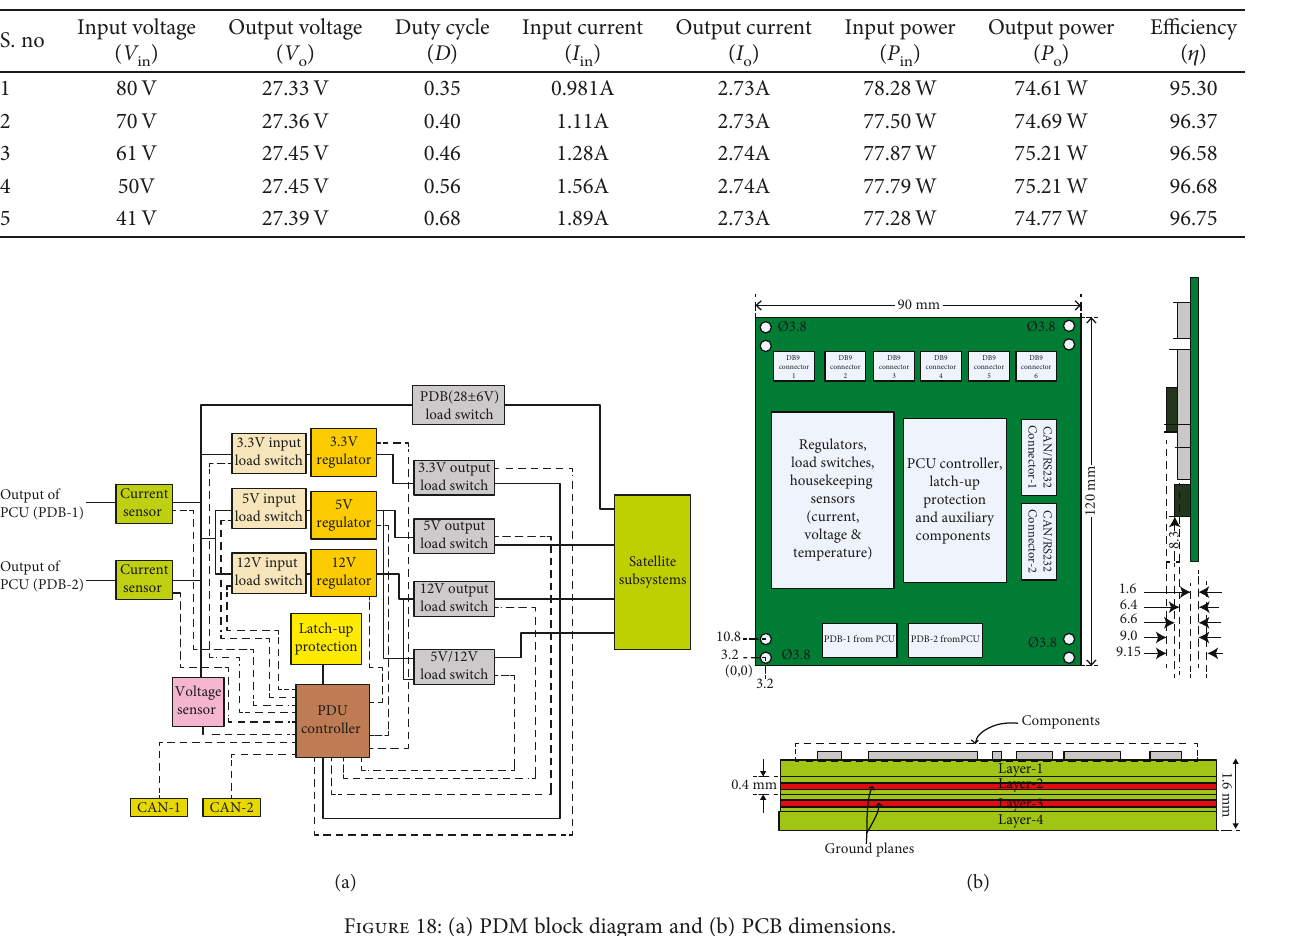
Table 2: Simulation results of MPPT buck converter designed for PCM.